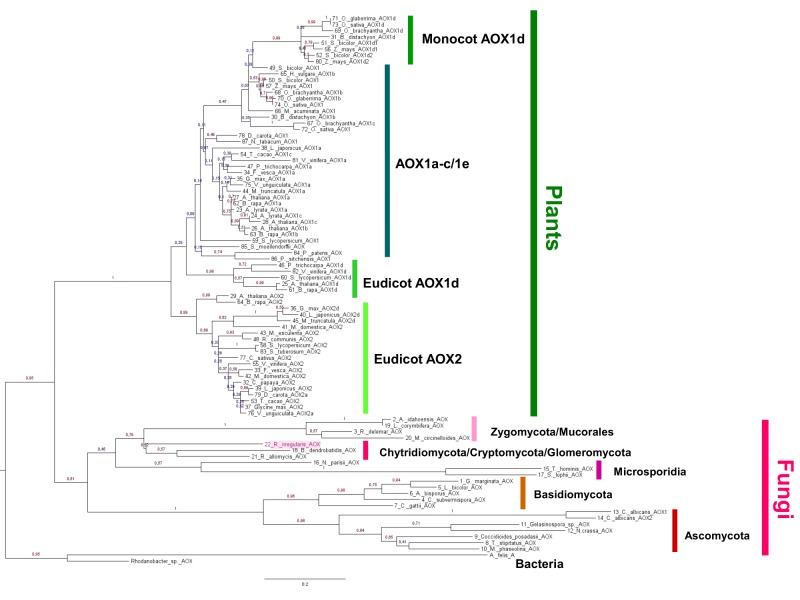
Maximum likelihood phylogenetic analysis of AOX protein sequences in fungi and plants.Two bacterial AOX sequences were placed as outgroup (Rhodanobacter sp. and Afipia felis). Location of R. irregularis is shaded. Fungal and plant AOX protein sequences were clearly separated by a ML bootstrap value of 0.95. The fungal sequences were grouped on two major clades, supported by a ML bootstrap value of 0.61: the Basidiomycota/Ascomycota clade, and a clade containing the Chytridiomycota, Cryptomycota, Glomeromycota, Microsporidia and Zygomycota phyla. Basidiomycota were separated from Ascomycota by a ML bootstrap of 1.